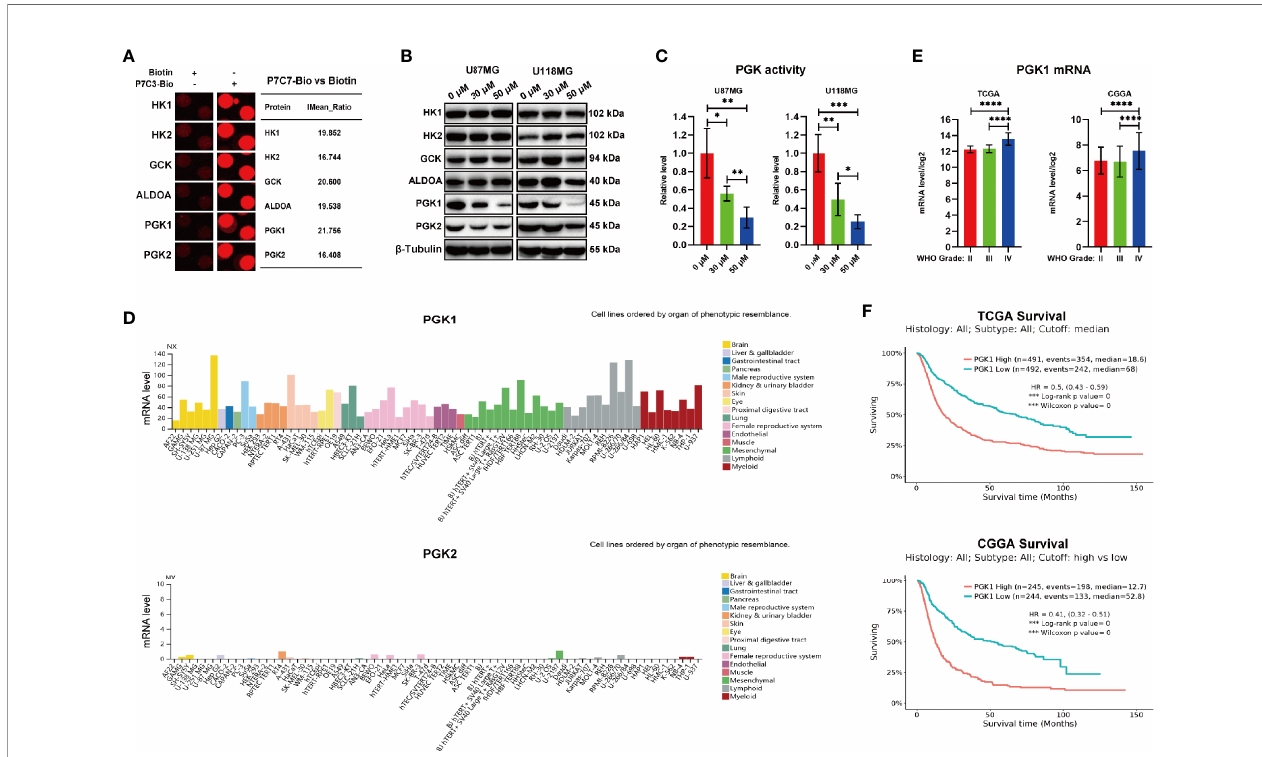
FIGURE 3 | P7C3 reduces the protein level of PGK1 and PGK2. (A) Representative spots of P7C3 target proteins, including the glycolytic process. (B) Western blotting for detecting protein levels of P7C3 target proteins that are related to glycolysis after U87MG and U118MG cells were treated with P7C3 at a concentration of 0 m M, 30 m M, and 50 m M for 24 h. (C) PGK1 activity levels in P7C3-treated U87MG and U118MG cells at a concentration of 0 m M, 30 m M, and 50 m M (n = 4). (D) The expression pro fi les of PGK1 and PGK2 mRNA levels. Data were obtained from the Human Protein Atlas database. The images are available at: https://www. proteinatlas.org/ENSG00000102144-PGK1/cell, and (https://www.proteinatlas.rg/ENSG00000170950-PGK2/cell). (E) Statistical analysis of PGK1 mRNA level among WHO grade II-IV glioma. The data were based on TCGA and CGGA and are available at: http://gliovis.bioinfo.cnio.es/. (F) Kaplan – Meier survival analysis of PGK1 mRNA level in glioma patients. The data were based on TCGA and CGGA and are available at: http://gliovis.bioinfo.cnio.es/. (The data were expressed as mean ± SD, * P < 0.05, ** P < 0.01, *** P < 0.001, **** P <